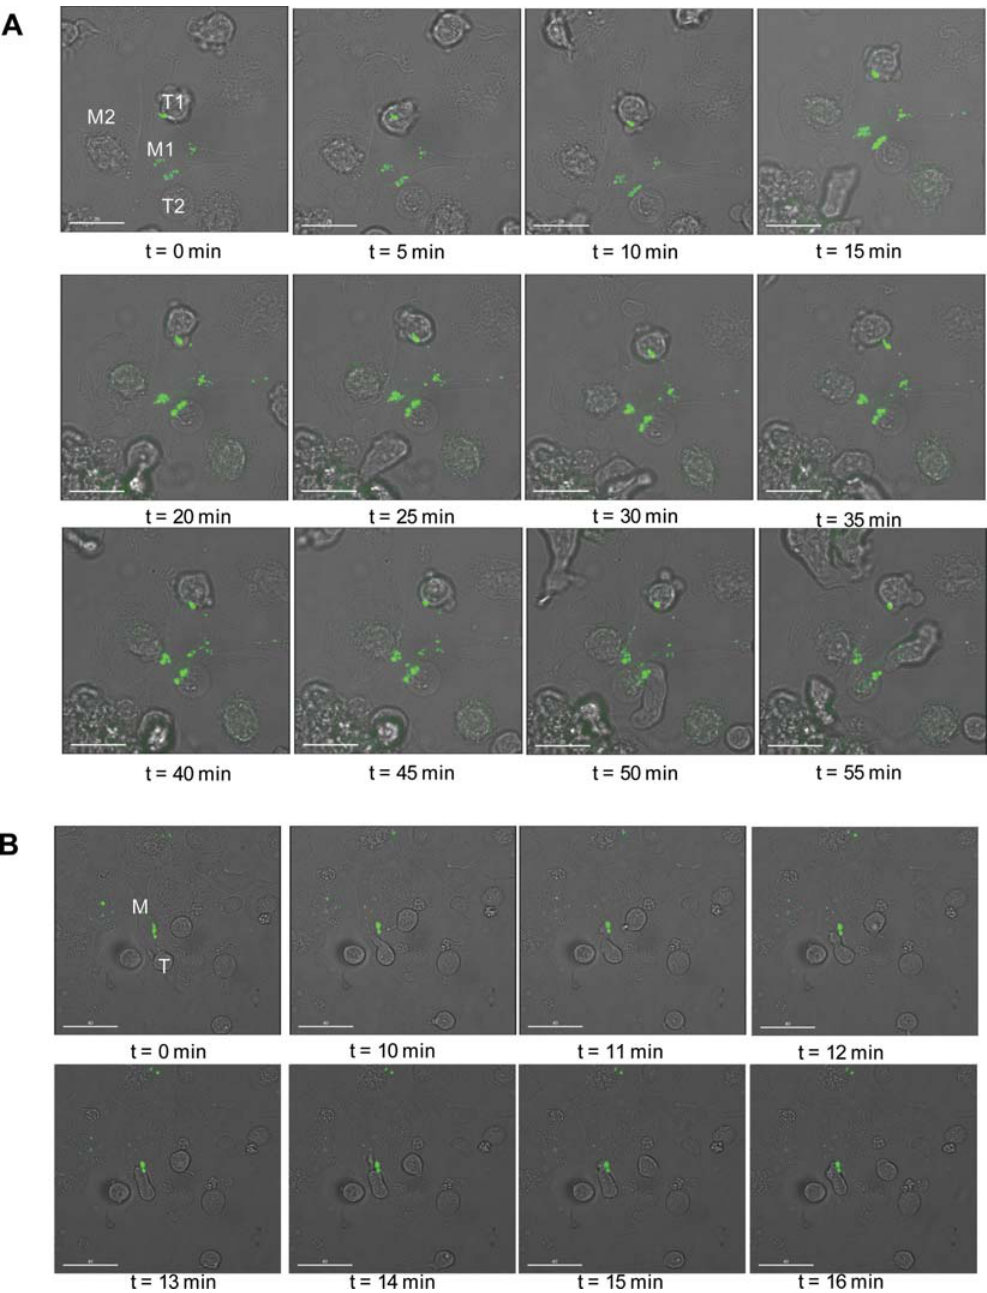
Figure 9. Real-time trafficking of Gag to the synapse in infected MDMs. (A) MDMs infected with VSV-G-pseudotyped NL4-3/MA-TC virus were labeled with FlAsH 48 hrs postinfection. Jurkat T-cells were added to the FlAsH-labeled cultures and incubated on the microscope stage in a closed chamber (37 u C /5% CO 2 ). Time t=0 min is 40 min (gallery A) or 70 min (gallery B) after addition of Jurkat cells. M1=infected MDM; M2=non- infected MDM; T1 and T2 are Jurkat T-cells. Scale bars=20 m m in A and 40 m m in B. For a movie of Gag movement to the synapse, derived from